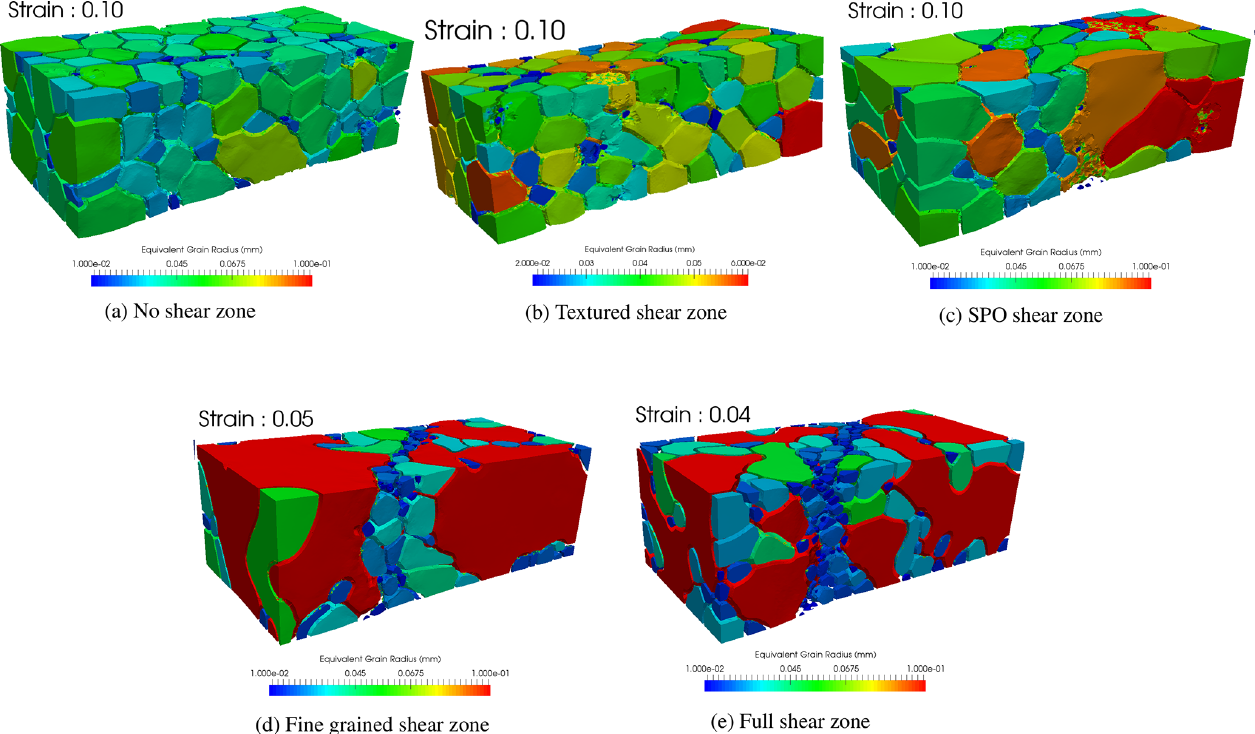
Figure 8. 3D view of the microstructure (colors represent equivalent grain radius) for no pre-existing (a) , textured (b) , SPO shear zones (c) after 10% of macroscopic deformation, for small grain size (d) after 5% of macroscopic deformation and for textured plus small grain size shear zone (e) after 4% of macroscopic